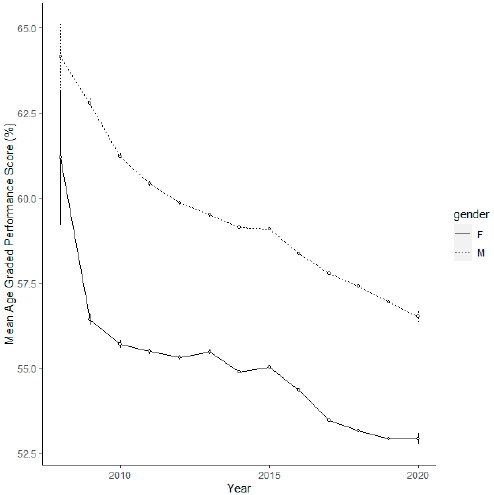
Figure 1. The AGPS of male and female participants separated by year at Scottish parkrun events. The error bars are 95% confidence intervals.